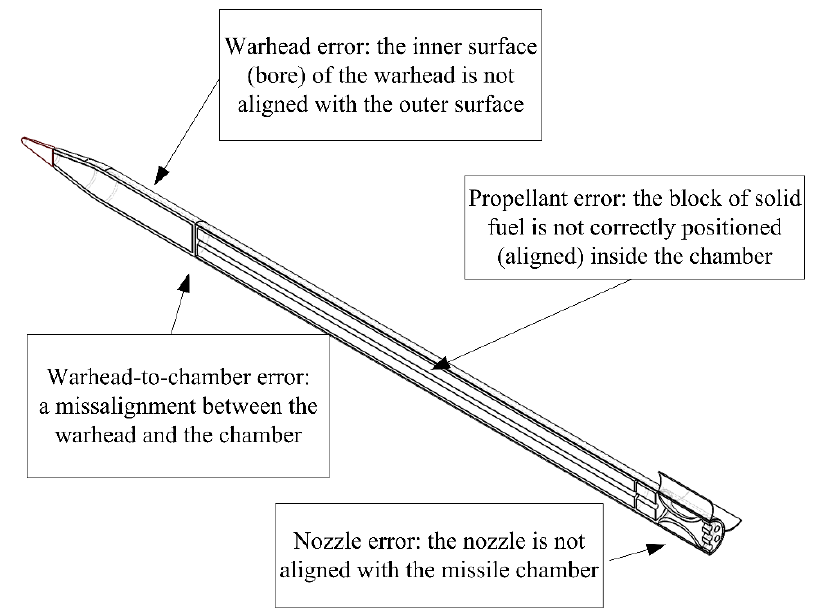
Figure 1. Parametric 3D CAD model of the rocket; manufacturing errors marked.